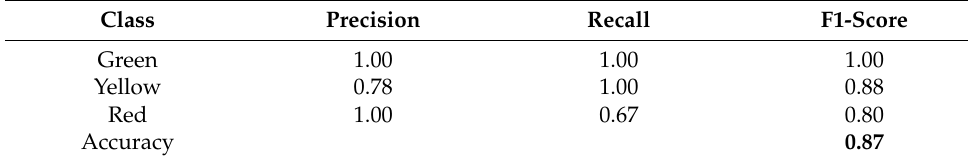
Table 4. Classification report for the GB classifier.